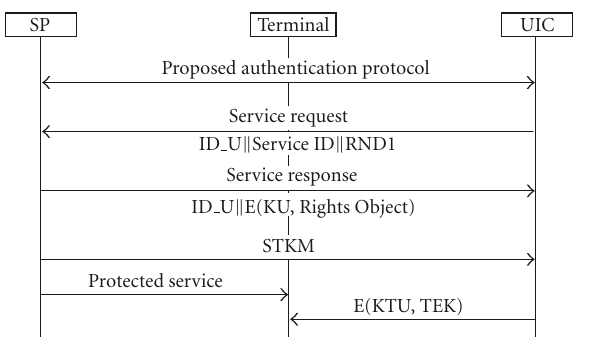
Figure 5: Mobile broadcast system with the proposed authentica- tion scheme.